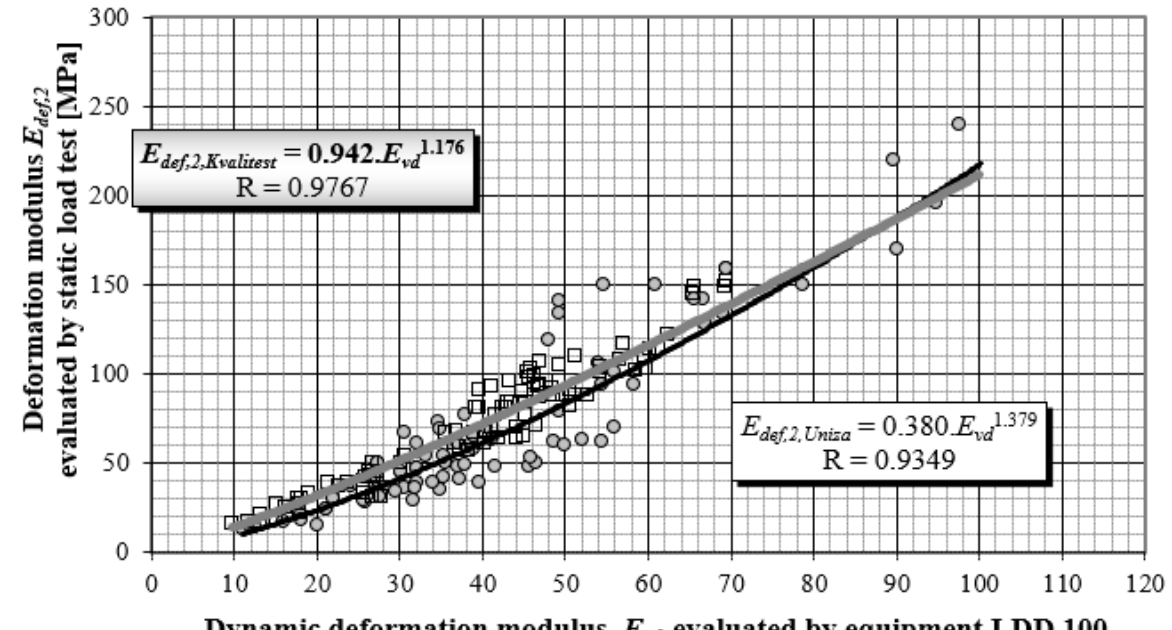
Figure 12. Power correlation dependency of E def, 2 on E vd during the years 1995–2020 by authors from the University of Zilina in cooperation with Kvalitest company.